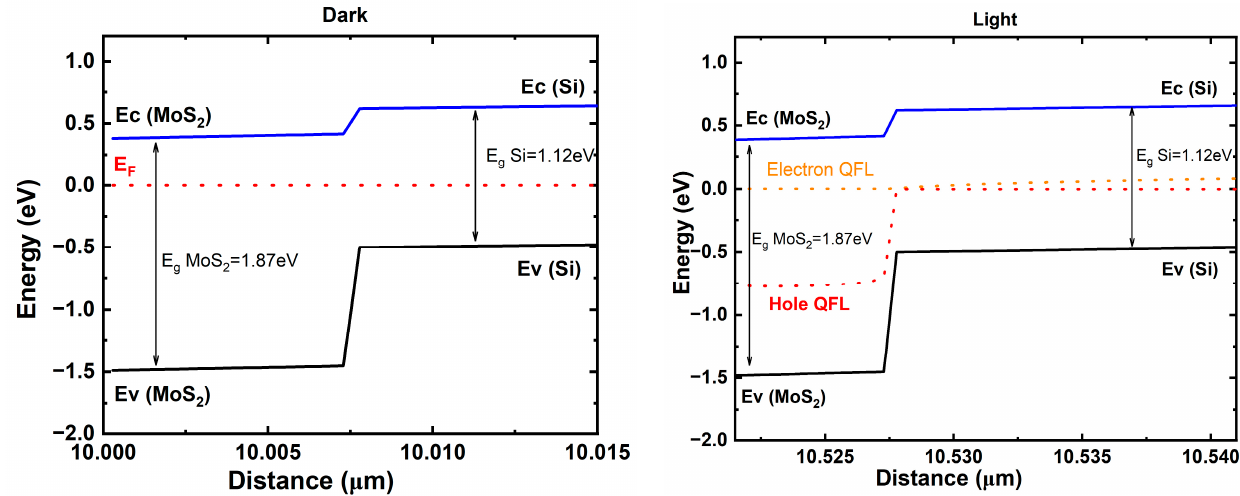
Figure 9. Simulated band diagram of MoS 2 /Si heterojunction solar cell in the vicinity of the MoS 2 /Si interface (dark and AM 1.5 light illumination, 0 Volt bias) .